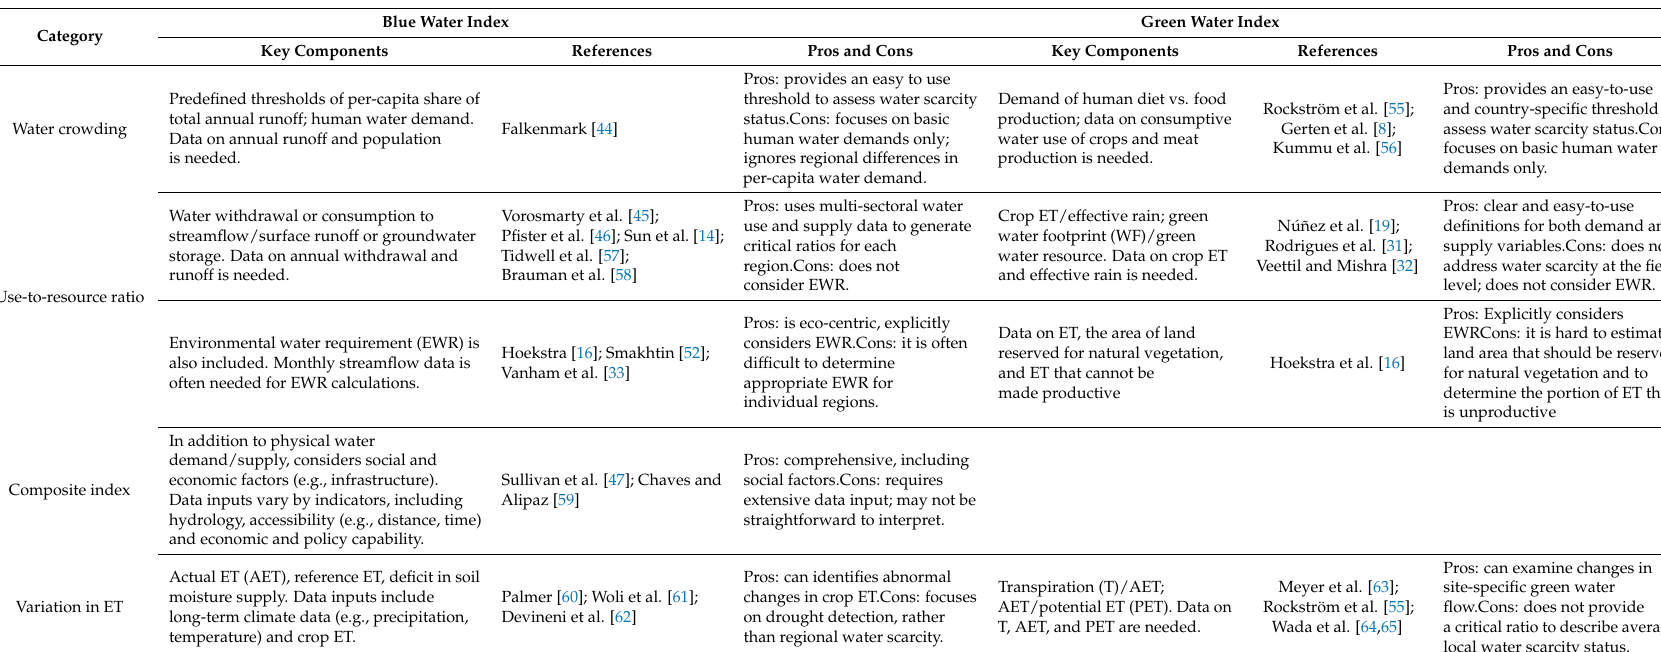
Table 1. Summary comparison of existing water availability or stress or scarcity